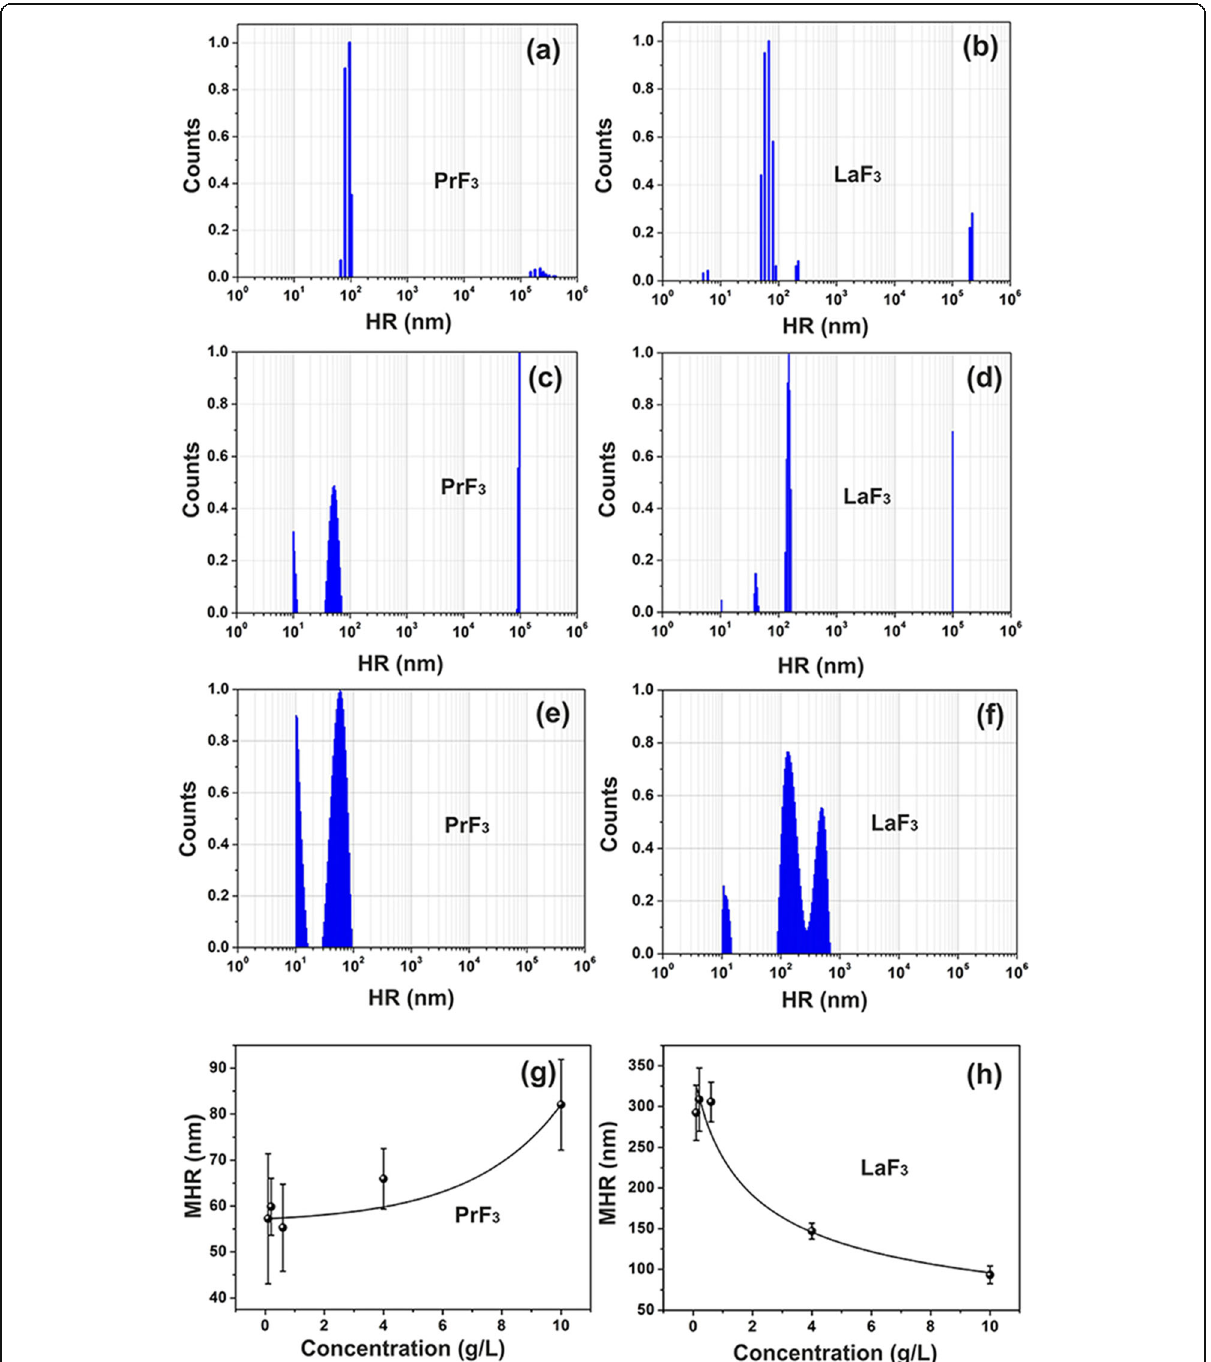
Fig. 1 DLS size distribution spectra of RE suspensions. a, b PrF 3 and LaF 3 NPs (5 g/L) in water. c, d PrF 3 and LaF 3 NPs (5 g/L) in DMEM+FBS. e, f PrF 3 and LaF 3 NPs (0.1 g/L) in DMEM+FBS. g, h Mean hydrodynamic radius (MHR) with standard deviation of PrF 3 and LaF 3 NPs in DMEM+FBS at different concentration